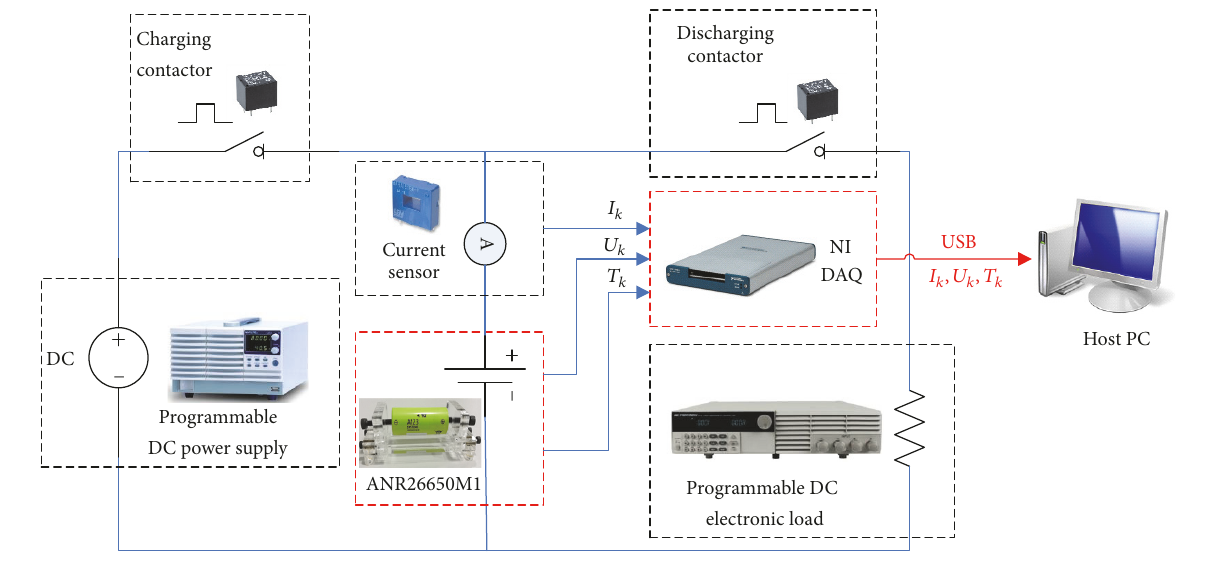
Figure 8: Test bench setup for battery cell testing [8].